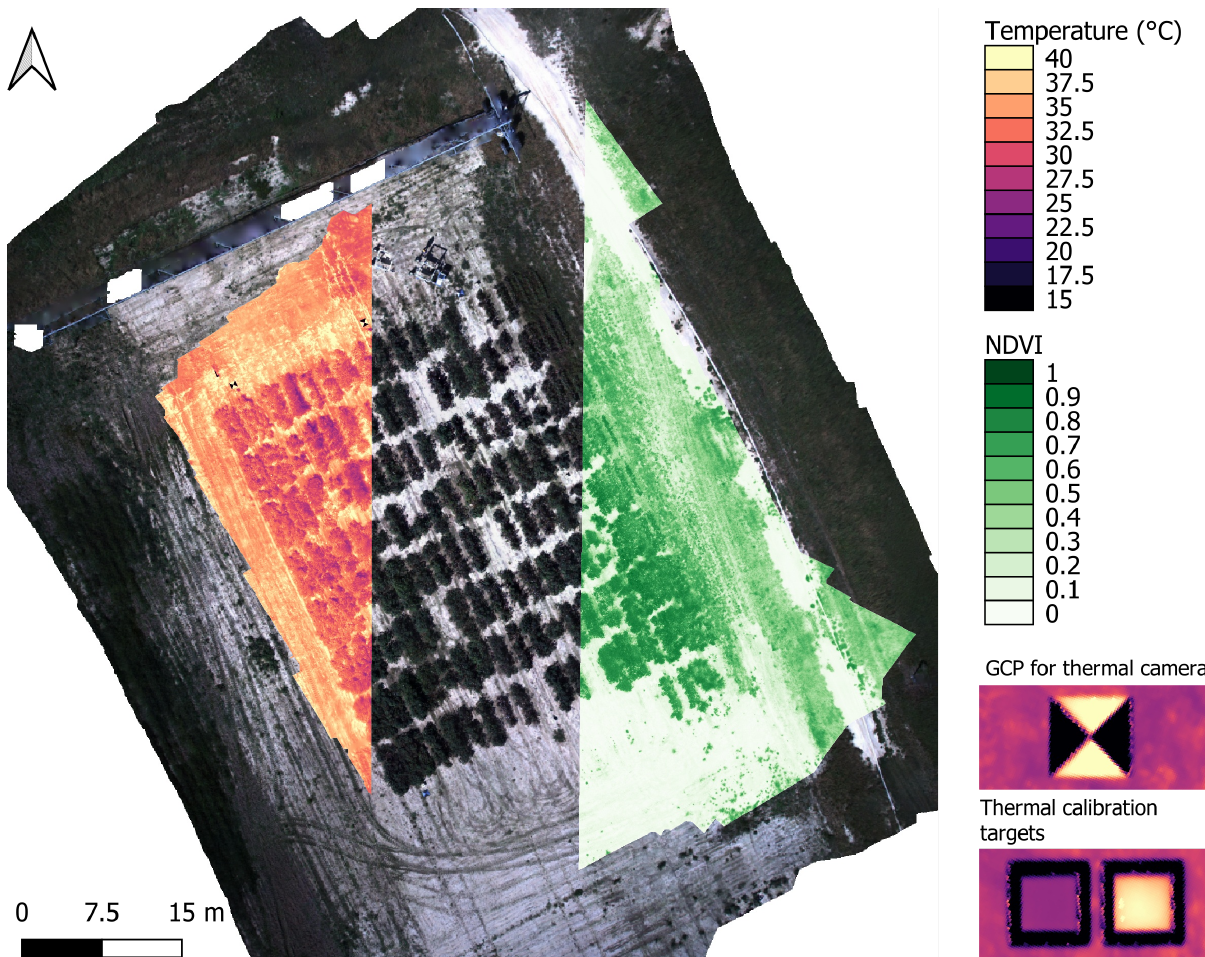
Figure 17. Overlay of UAV-derived orthomosaics, including RGB (background), temperature (section of mosaic; light yellow to black), and NDVI (section of mosaic; light green to dark green). Zoom-in images showing calibration targets, and the GCPs for the thermal camera are also displayed (bottom